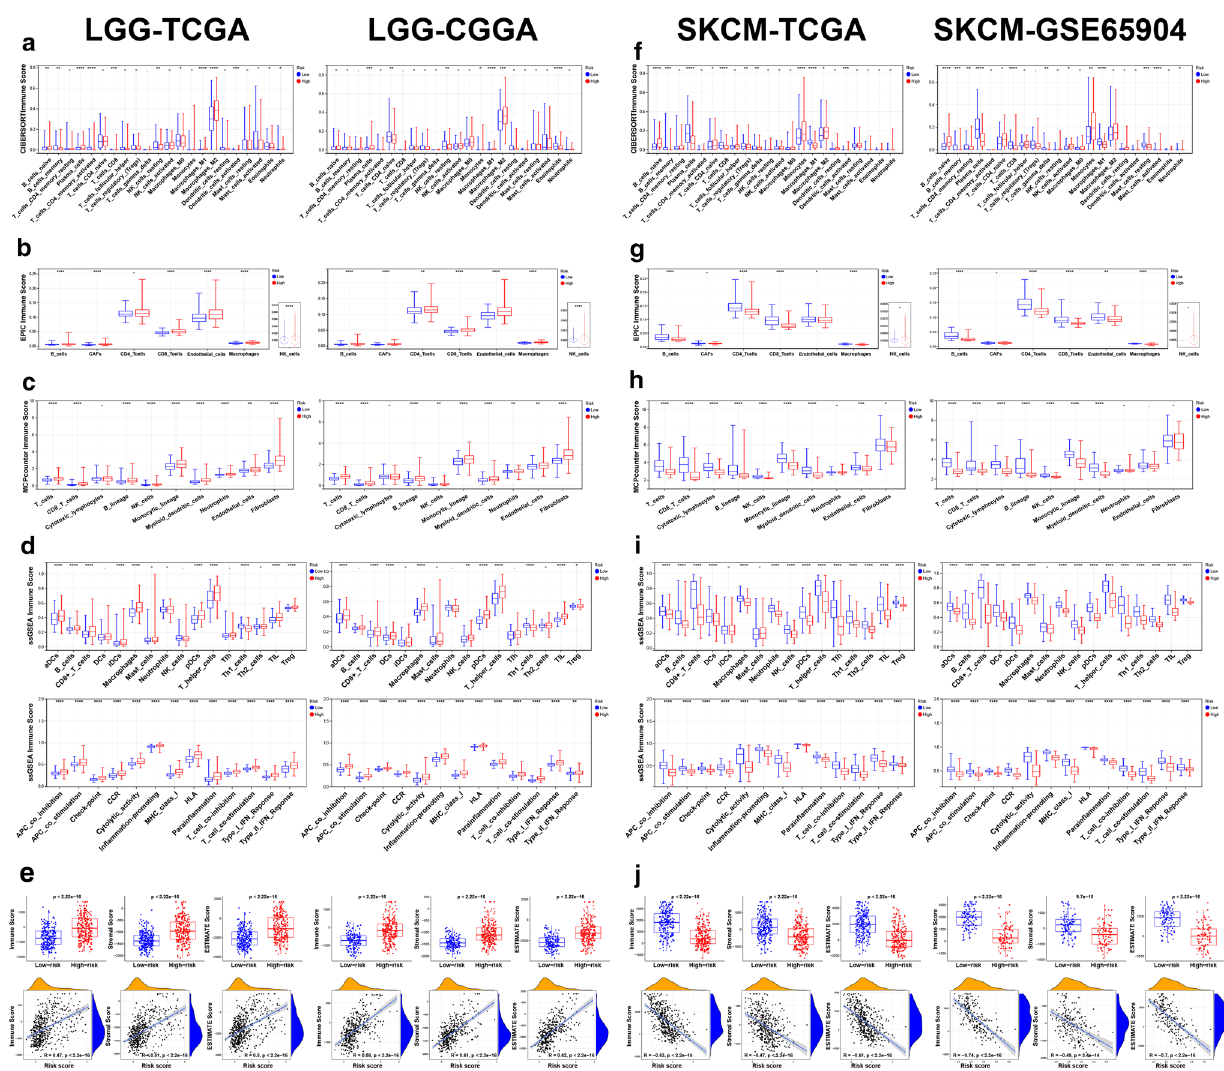
Fig. 9 Immune infiltration analysis. The box plots and violin plots showed the difference of immune infiltration level and immune function between low- and high-risk groups of LGG and SKCM patients based on CIBERSORT ( a , f ), EPIC ( b , g ), MCPcounter ( c , h ) and ssGSEA ( d , i ), with Wilcoxon signed-rank test applied. *p < 0.05; **p < 0.01; ***p < 0.001; ****p < 0.0001. The scatter diagrams ( e , j ) showed the relationship between risk score and immune score, stromal score as well as ESTIMATE score, with Spearman’s correlation coefficient R value and p value marked in the